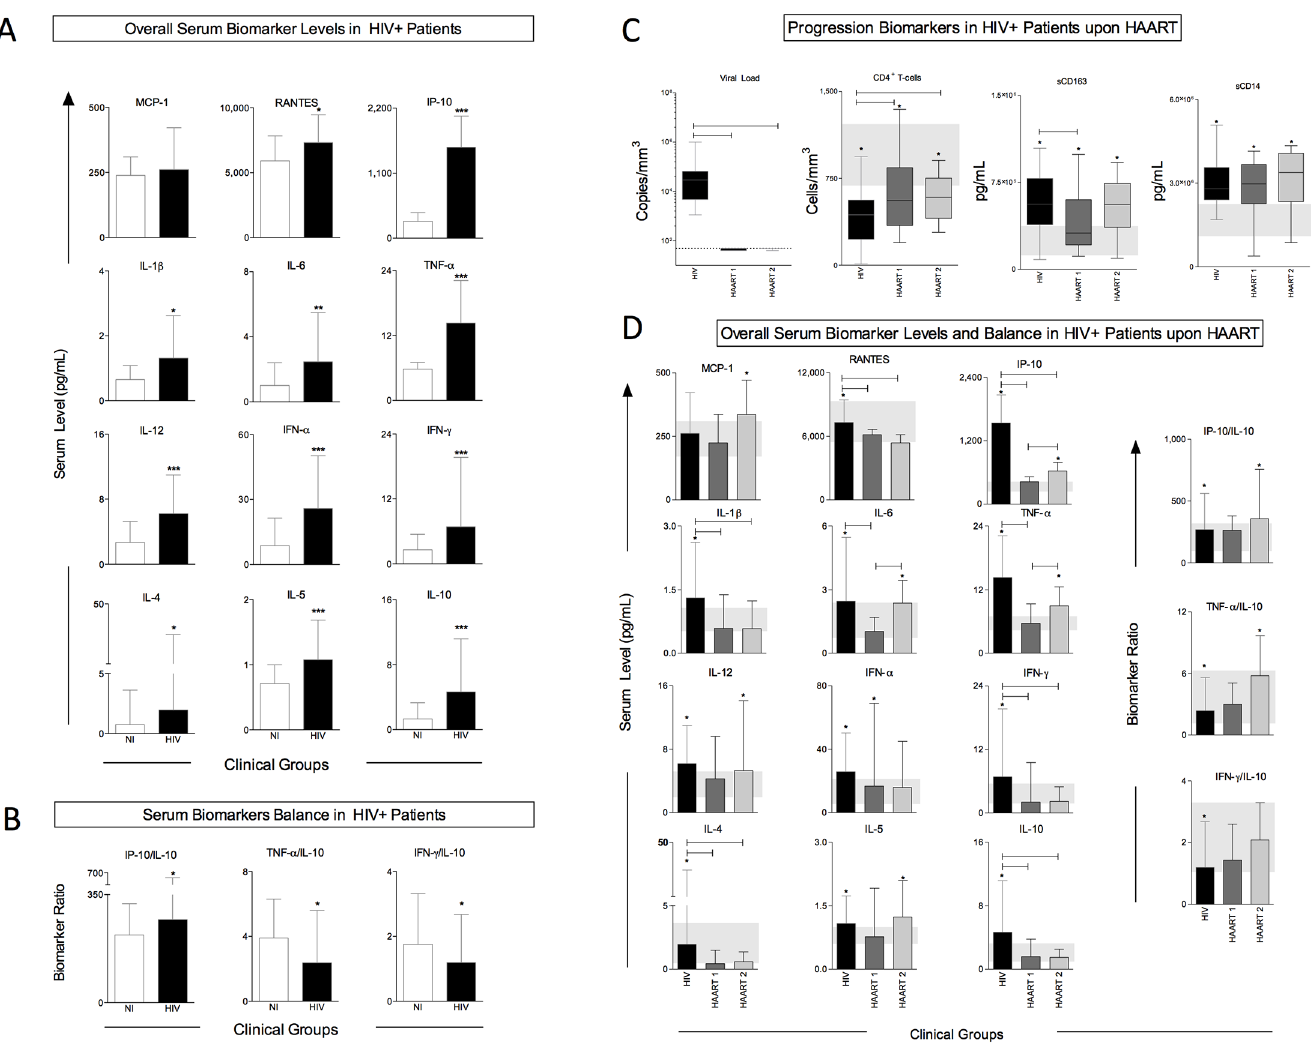
Fig 1. Immunological and progression biomarkers overall profile of untreated and treated HIV+ patients under different antiretroviral regimens. A) Overall immunological profile of untreated HIV+ patients; B) Biomarker ratio of untreated HIV+ patients; C) Progression biomarkers in HIV+ patients under HAART; D) Overall immunological profile of HIV+ patients under HAART. Plasma progression biomarkers and immunological biomarkers were obtained by quantification of viremia, CD4+ T cells counts, sCD14, sCD163, and MCP-1, RANTES, IP-10, IL-1 β , IL-6, TNF- α , IL-12, IFN- α , IFN- γ , IL-4, IL-5, and IL-10 in plasma. Results are expressed as median ± interquartile range. *** p < 0.001; ** p < 0.01; * p < 0.05 vs. NI; p < 0.05 between indicated groups. The interquartile range of NI group is expressed as a gray rectangle under the bars. NI: Non-infected individuals. HIV: Untreated HIV+ patients.